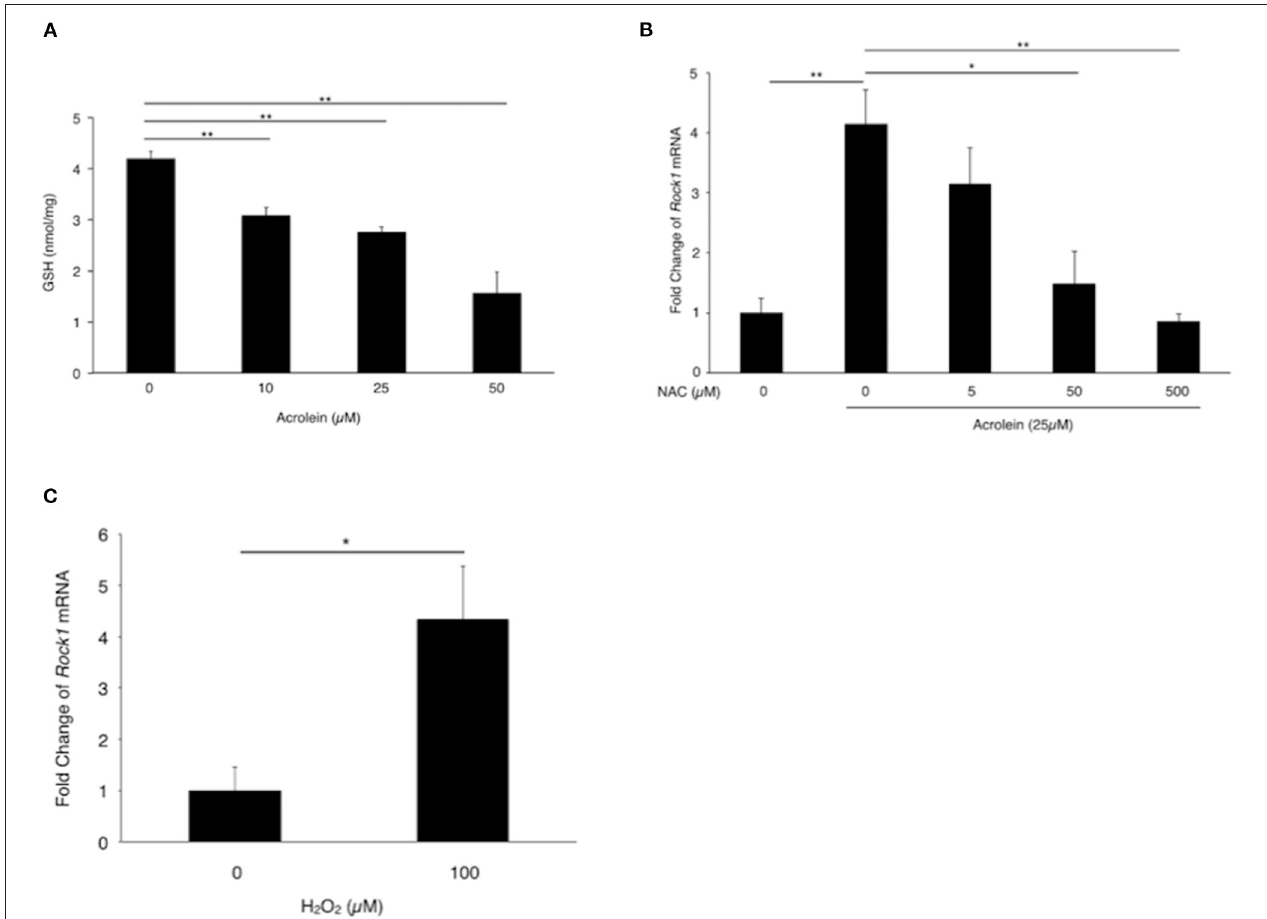
FIGURE 4 | Impact of acrolein stimulation on antioxidant defense systems in TR-MUL5 cells. (A) Total GSH levels when TR-MUL5 cells were exposed to acrolein for 3h. (B) Rock1 mRNA levels in acrolein-stimulated TR-MUL5 cells with or without treatment of N-acetylcysteine (NAC) ( n = 3 each). (C) Rock1 mRNA levels in TR-MUL5 cells treated with or without hydrogen peroxide ( n = 3 each). Values represent mean ± SEM; * P < 0.05; ** P < 0.01.